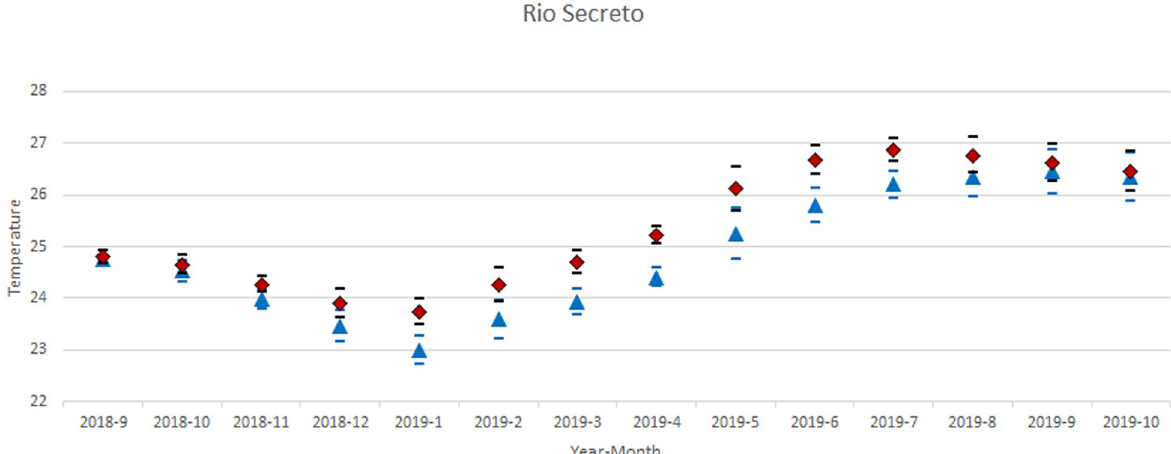
Fig 7. Comparison of GLIMMIX models of aphotic and photic zones in Rı´o Secreto (Tuch). The diamonds and black error bars are for the dark zone and the blue triangles and error bars are for the light zone. The seasonal cycle is apparent as is the greater variation during the winter months.